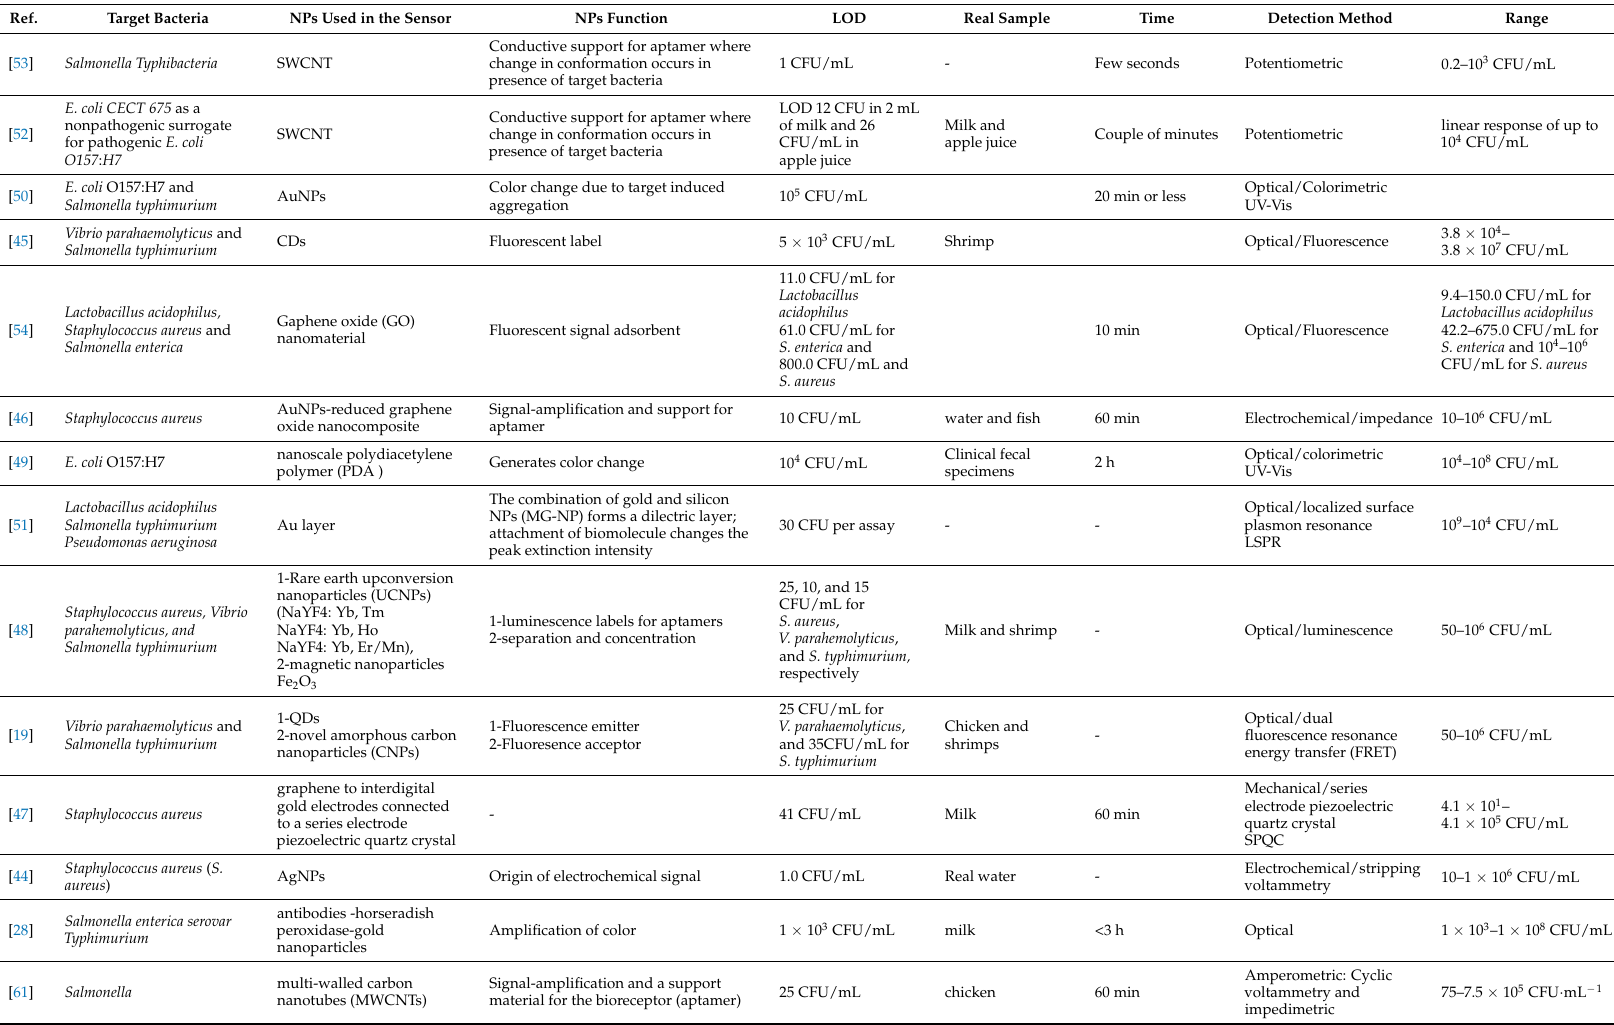
Table 1. Aptamer-based biosensors for bacteria detection.